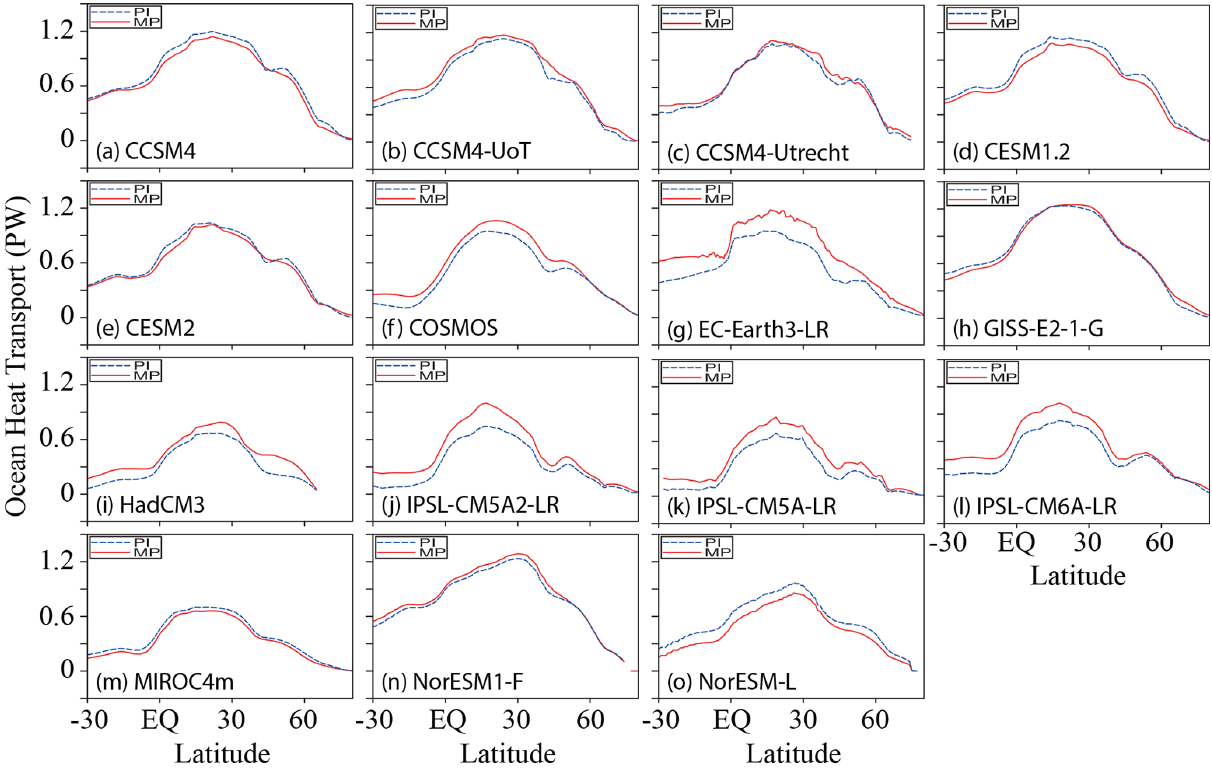
Figure 3. Simulated Atlantic poleward oceanic heat transport in PlioMIP2 (unit: PW). Blue dashed lines show the pre-industrial, and red solid lines show the